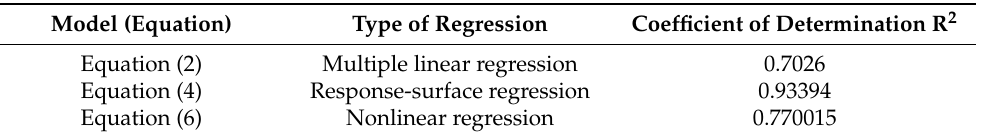
Table 7. Comparison of coefficient of determination with different regression models for Co–20Cr– 15W–10Ni